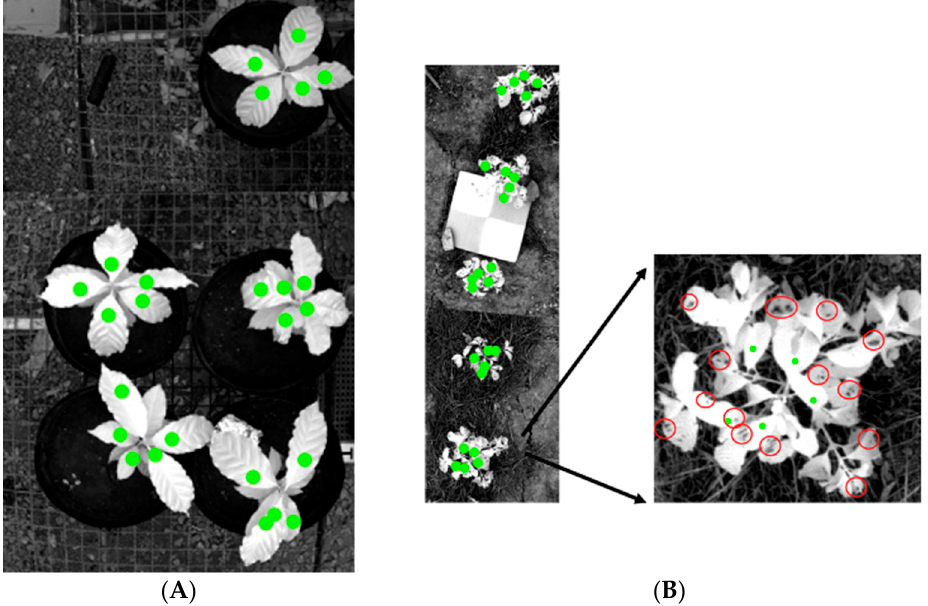
Figure 1. Images of the near-infrared band (NIR), obtained with a multispectral camera. ( A ): Leaves of healthy plants in the greenhouse and the green dots represent sampled points. ( B ): Leaves of infested plants in the field and the green dots represent sampled points. Zoomed area of one of the plants, where the red circles represent the coffee leaf miners.